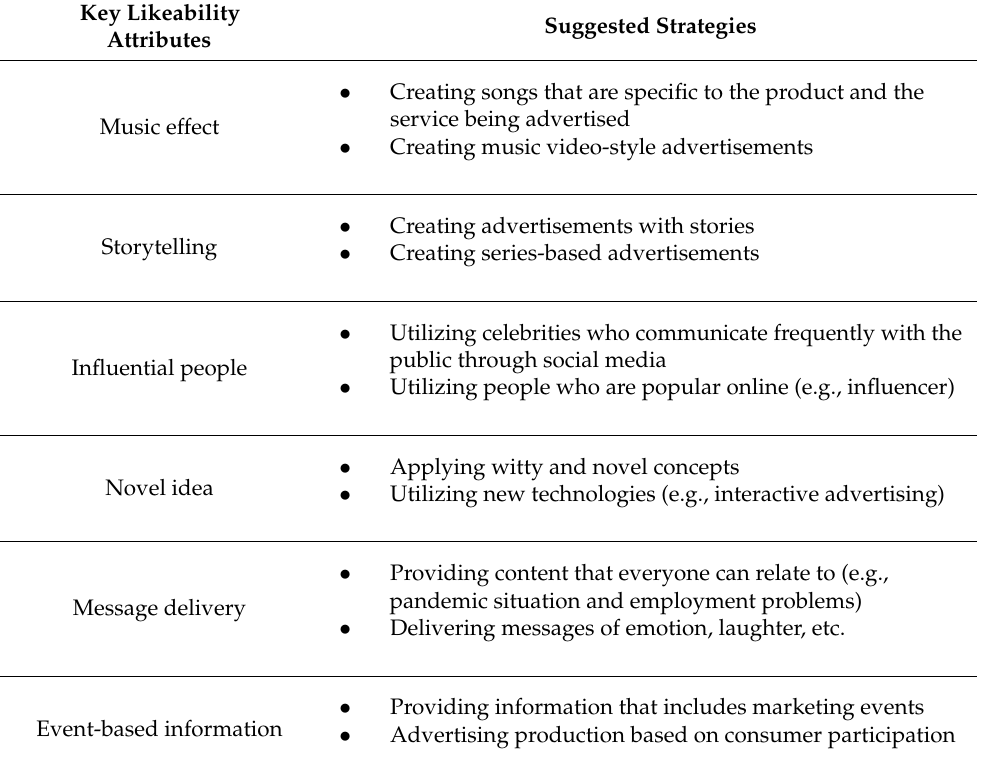
Table 6. Suggested strategies for online video